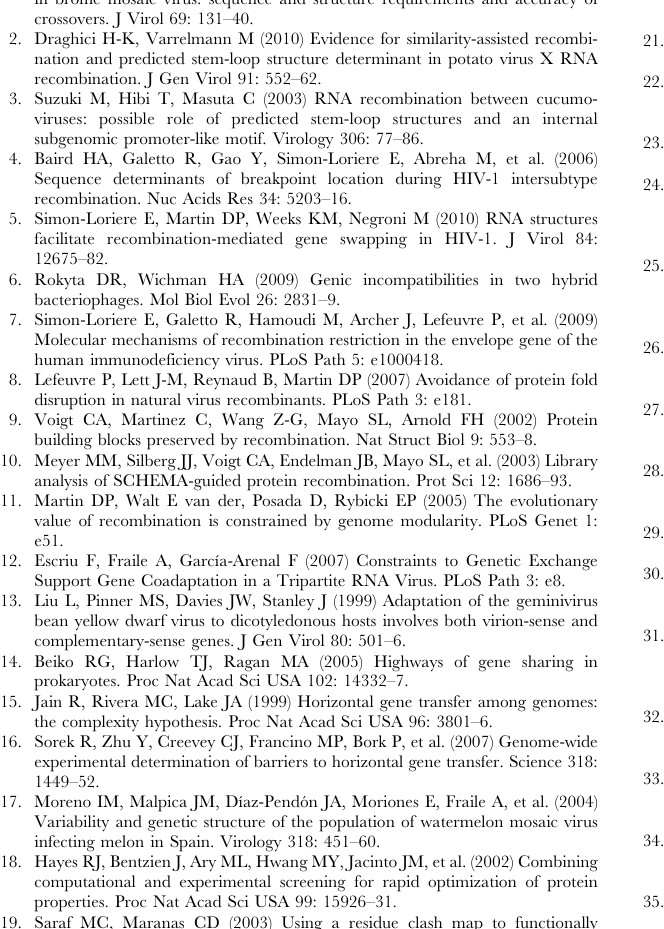
spots, blue areas represent recombination cold-spots. The positions of open reading frames (ORFs; horizontal arrows) and intergenic regions (IR) are represented on the top of the graph. Pink and blue horizontal lines beneath the ORF map respectively delineate the positions of recombination hot and cold spots detectable within begomovirus genomes sampled from nature (from Lefeuvre et al. [8]). Protocol S1 Supplementary methods and materials. Table S1 Summary of full genome sequences examined in this study. Table S2 Testing for an association between predicted genomic secondary structures and recombination breakpoint